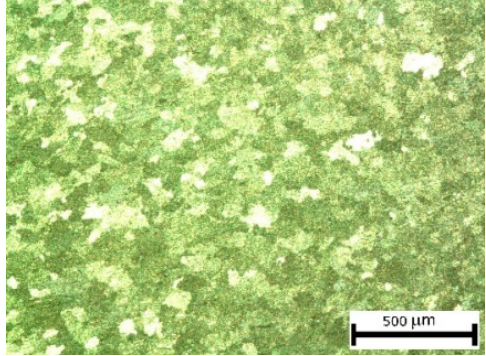
Figure 2. Grain dispersion of AA5754-H111 at light microscopy.